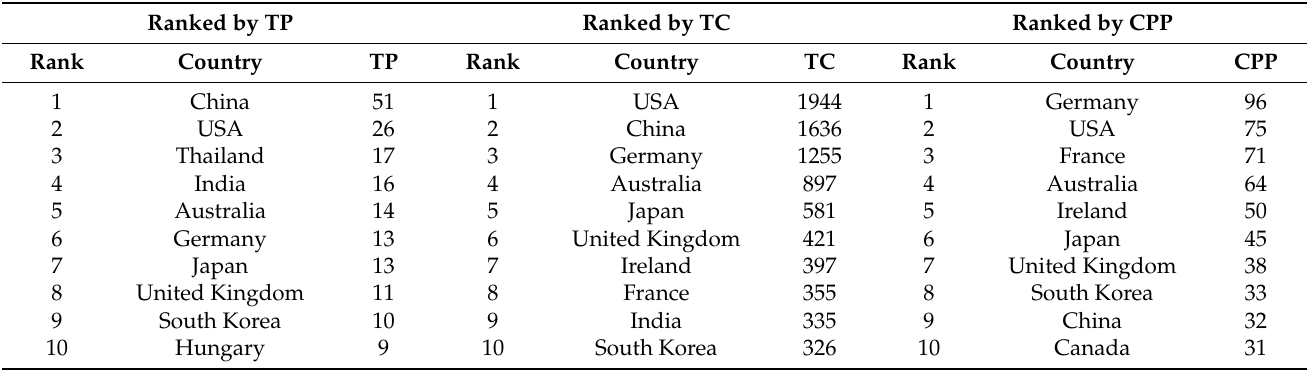
Table 3. Influential countries ranked by TP, TC, and CPP.